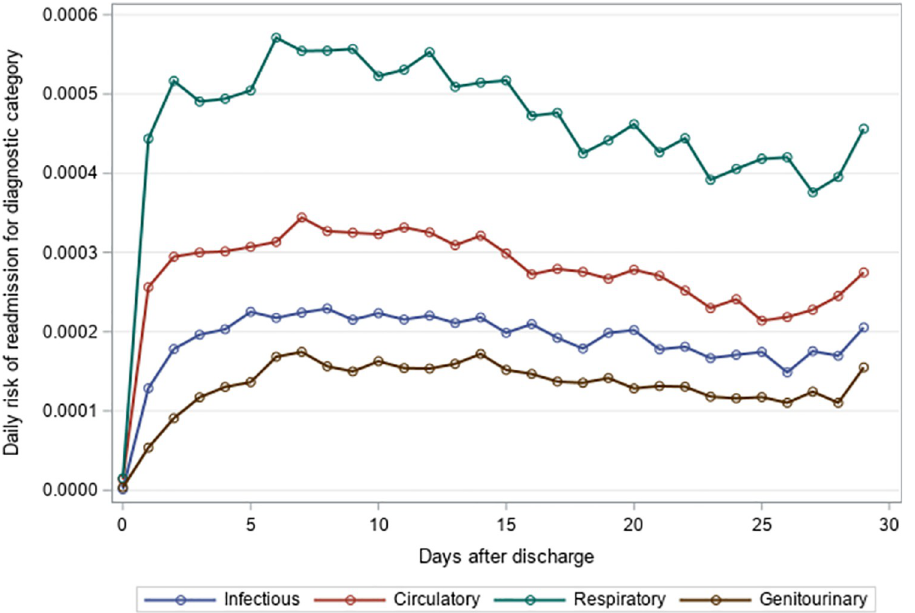
Fig 1. Daily risk of 30-day unplanned hospital readmission among older adults discharged to skilled nursing facilities following an index hospitalization for pneumonia, 2012–2013. Presents the daily risk of unplanned hospital readmission for four common causes of readmission (infectious, respiratory, circulatory, genitourinary). Each year started on the Sunday of Morbidity and Mortality Weekly Report week 27 and ended on the Saturday of Morbidity and Mortality Weekly Report week 26 of the following year.